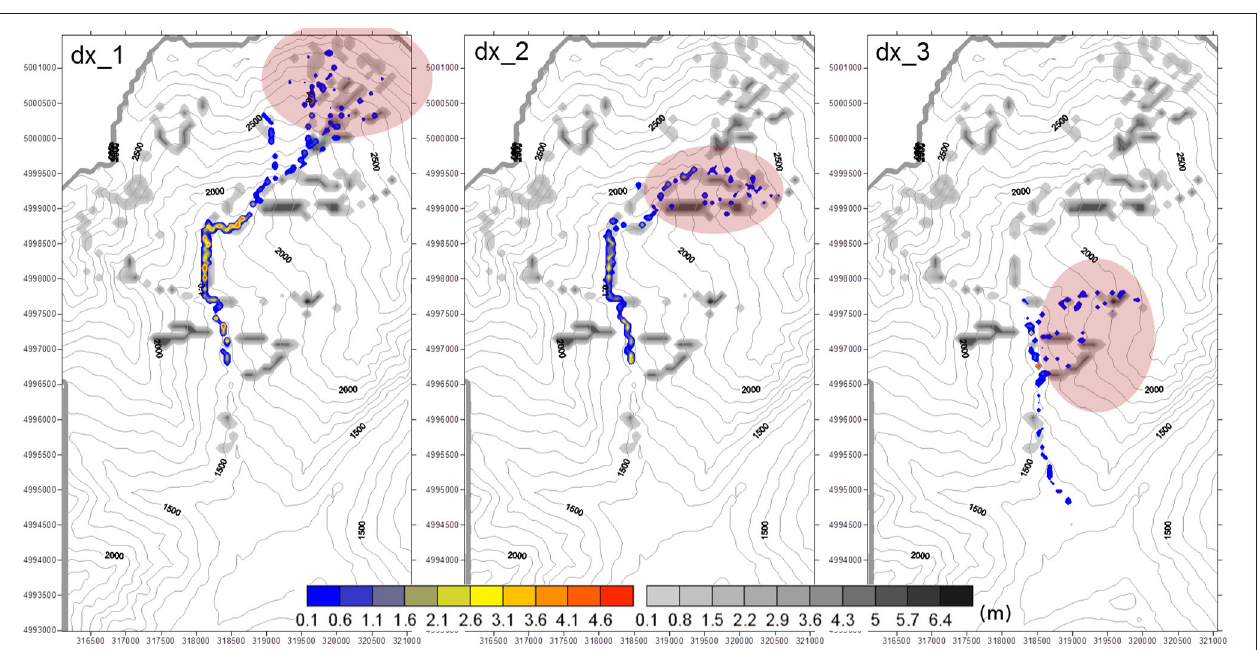
FIGURE 11 | Results of the numerical runs performed in the West area. Colored scale: simulated deposition patterns. Gray scale: initial deposits of sediments.